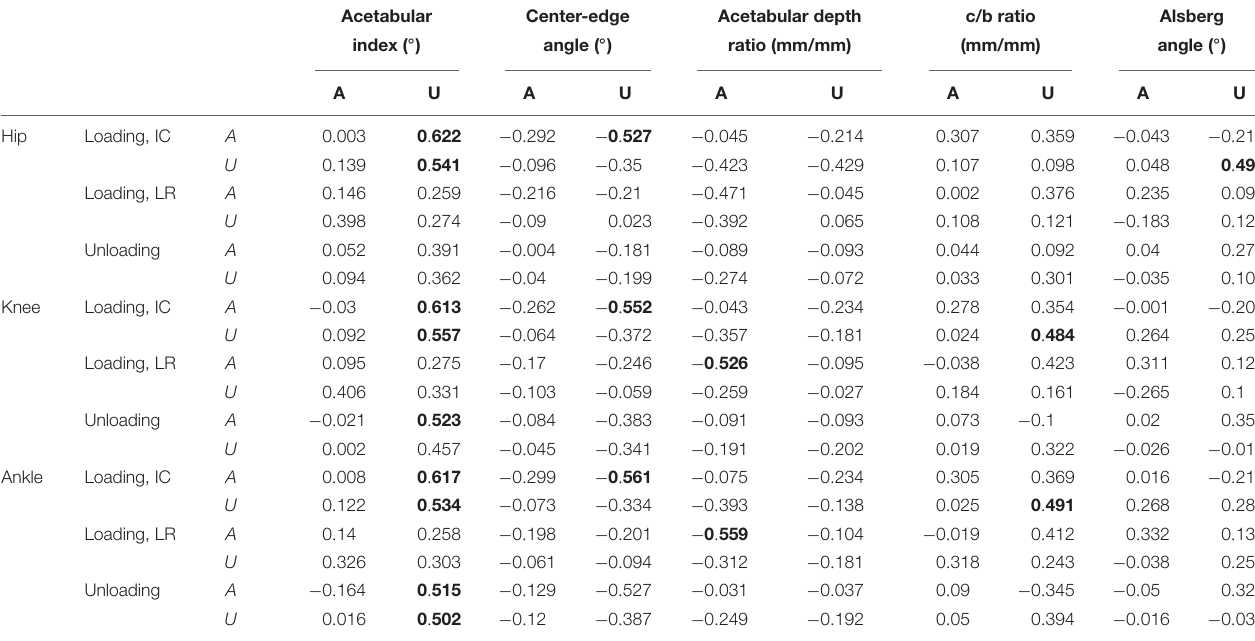
TABLE 5 | Correlations between loading and unloading rates of joint axial force and radiographic measurements of both affected (A) and unaffected (U)